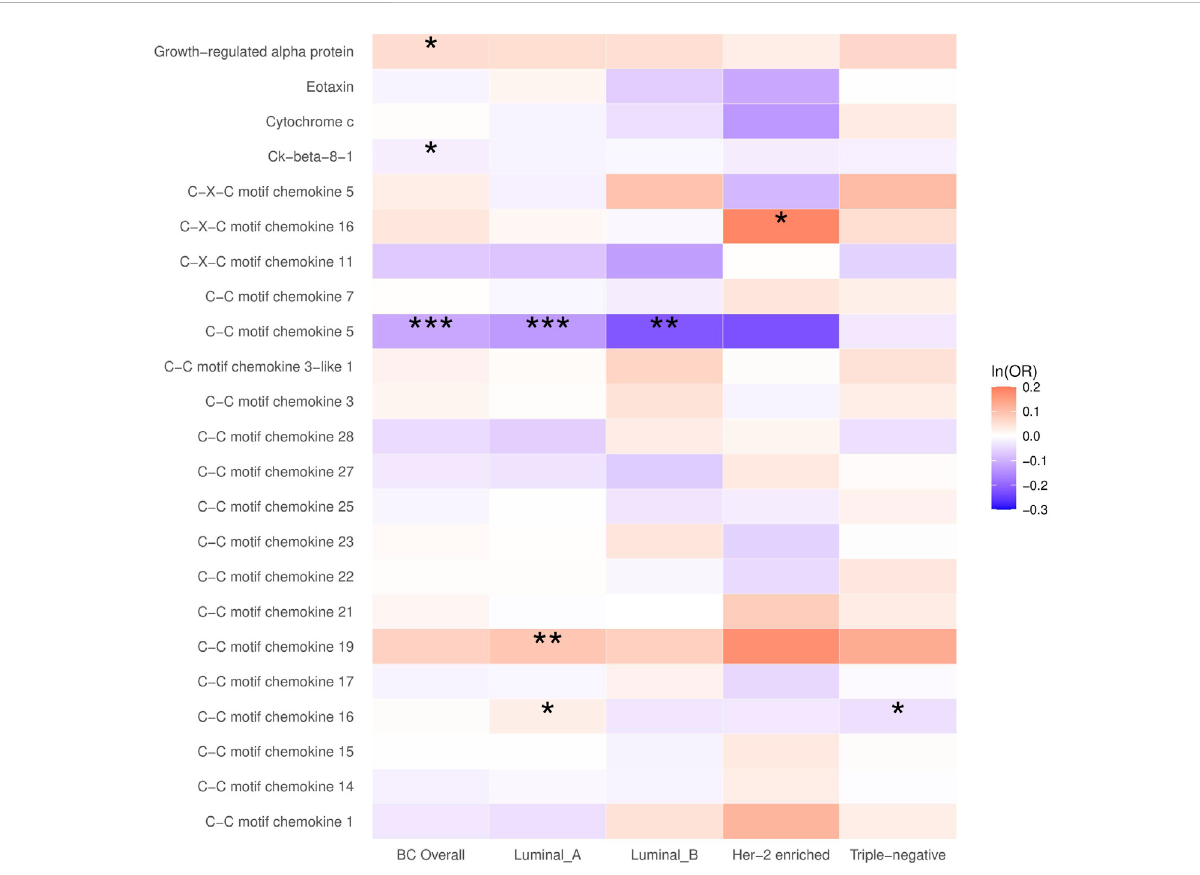
FIGURE 1 The causal association between plasma chemokines and breast cancer risk overall and by molecular subtype. OR: Odds ratio. Statistical signi fi cance is indicated by *** ( p < 0.001), ** ( p < 0.01) and * ( p < 0.05). The estimates are based on the fi xed effect of the inverse variance weighted method or Wald ratio method for meta-analyzing individual SNP results. ORs show the risk of breast cancer overall and by subtypes per SD increase of ranked-inverse normalized concentration in exposure to plasma